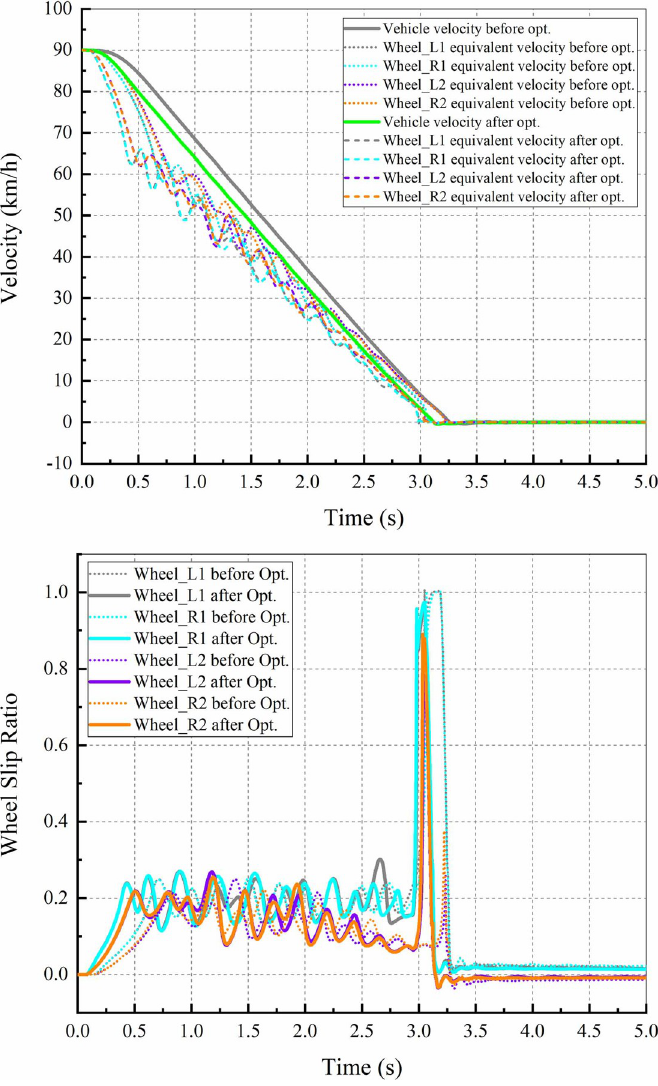
Fig 16. Comparison of ABS control. (a) Vehicle and equivalent wheel velocity; (b) Wheel slip ratios.